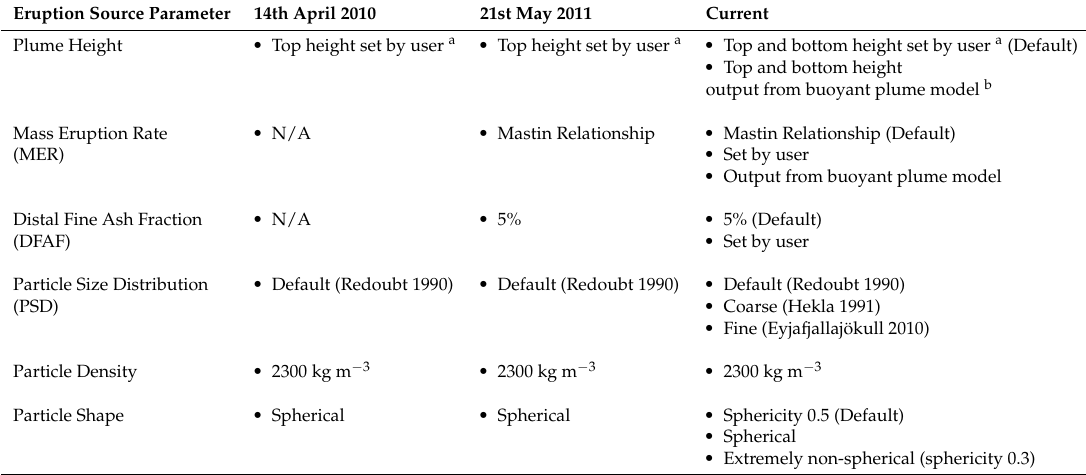
Table 1. Eruption Source Parameter (ESP) options in the London VAAC modelling